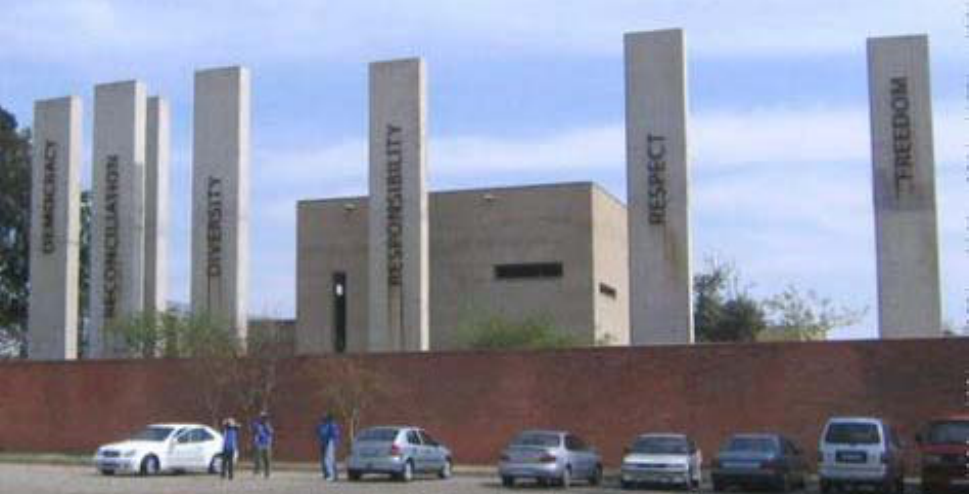
Figure 11. Pillars of the constitution at the entrance to the Apartheid Museum, Johannesburg (author’s